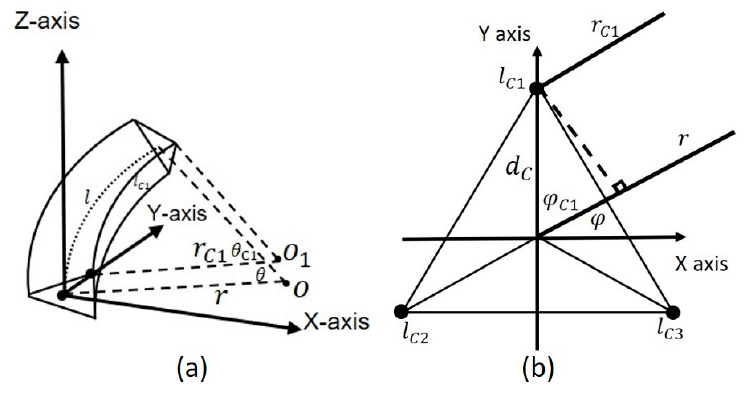
Figure 6. Relation between the tension cables and arc parameters: ( a ) three-dimensional and ( b ) two-dimensional.